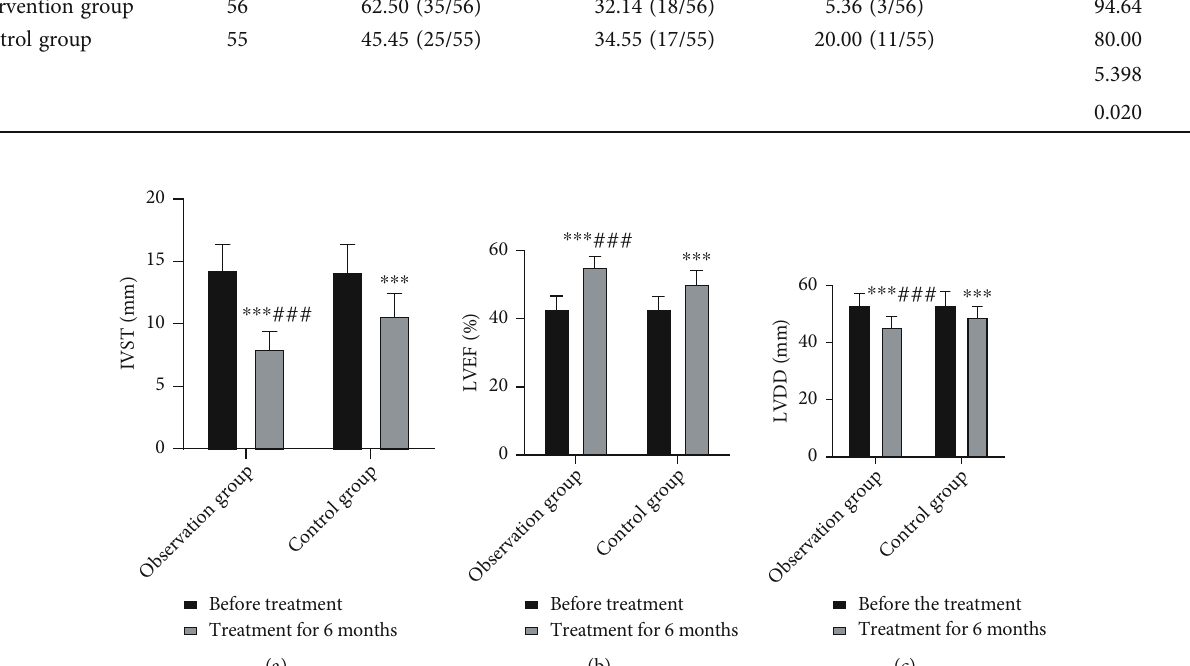
Figure 1: Comparison of cardiac function in both groups. (a) IVST; (b) LVDD; (c) LVEF. Compared with pretreatment, ∗∗∗ P < 0 : 001 ; compared with the control group, ### P < 0 : 001 .